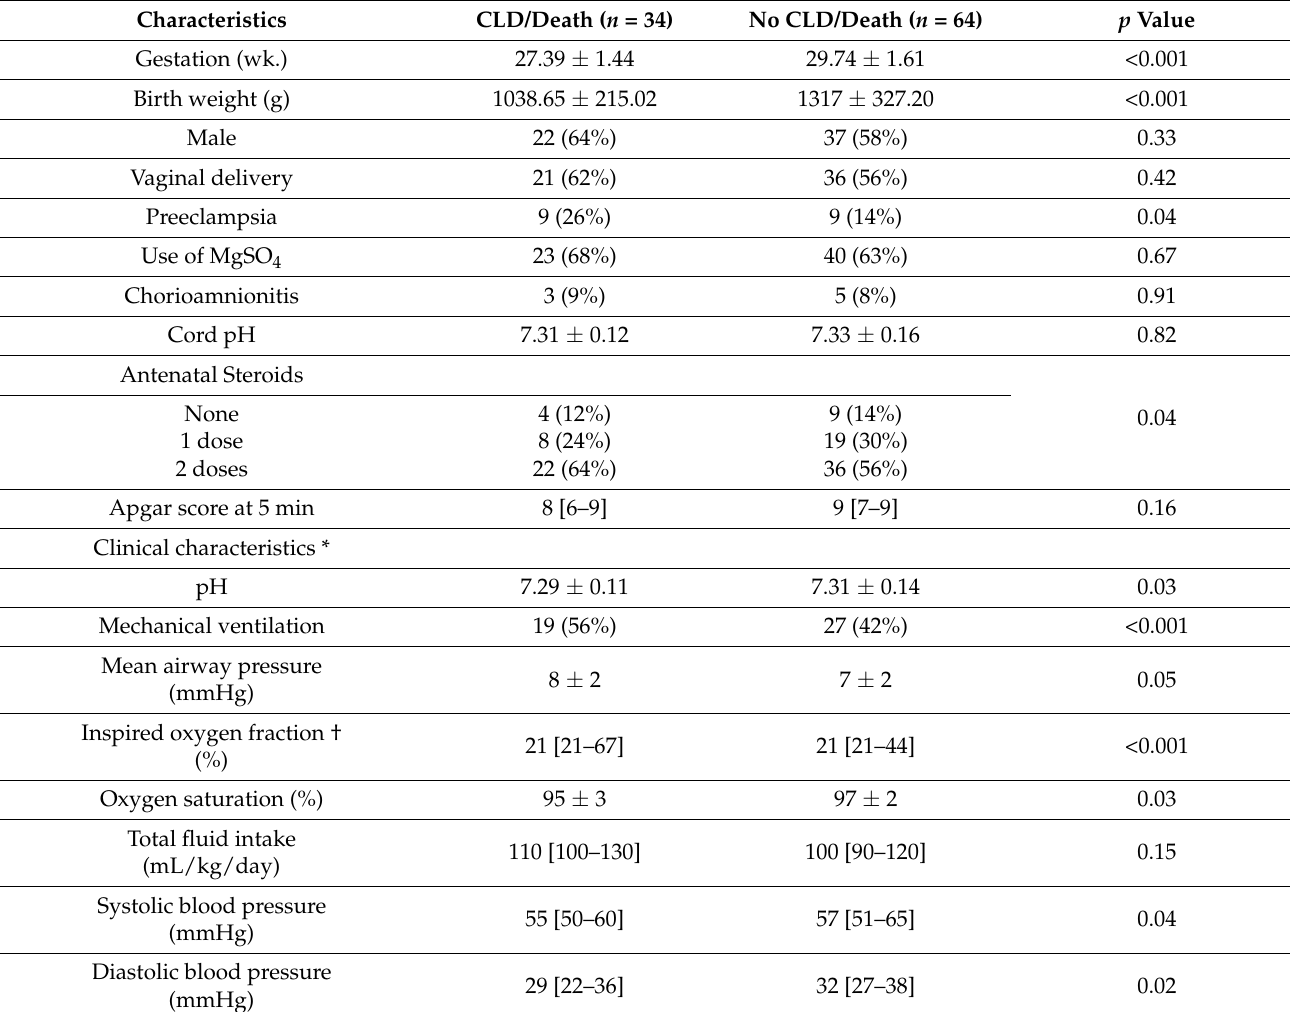
Table 1. Demographic characteristics and clinical details among both